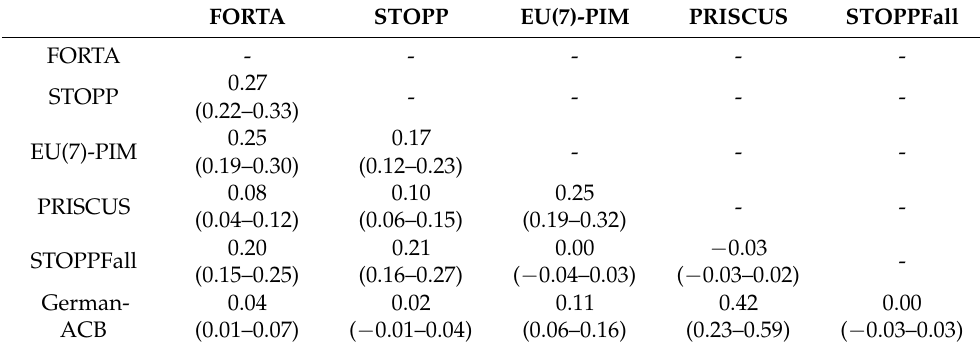
Table 7. Pairwise agreement (Cohen’s Kappa) of PIM detection via five different tools .